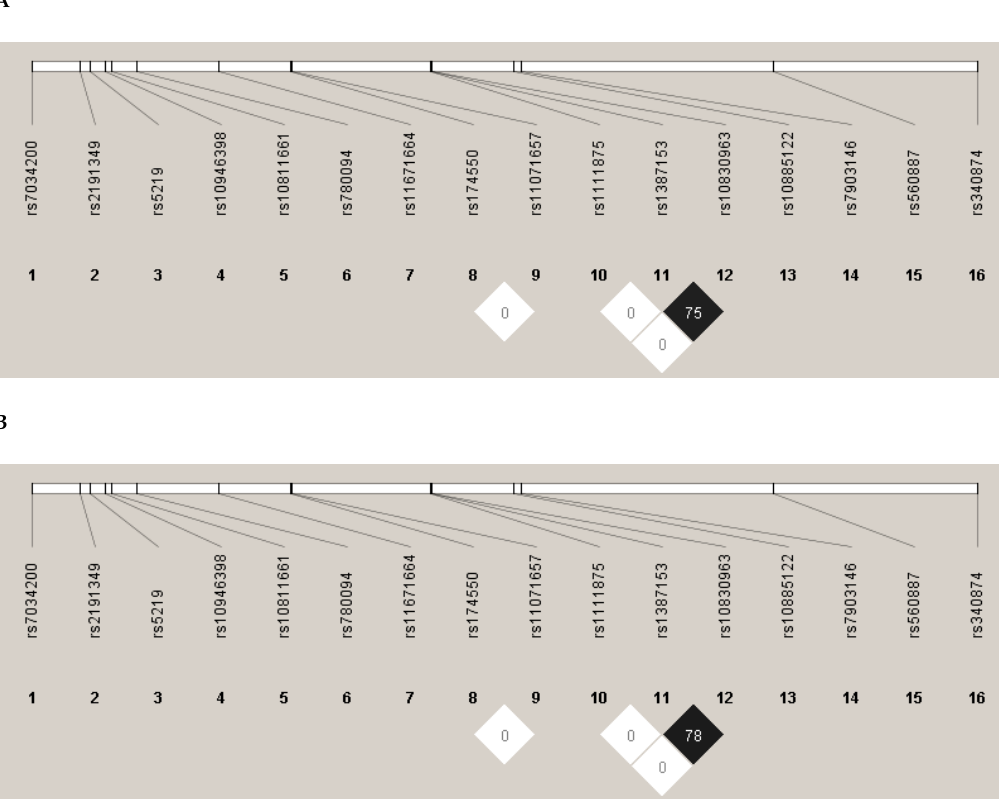
Table 4. Comparison of susceptible allele frequencies between study populations.